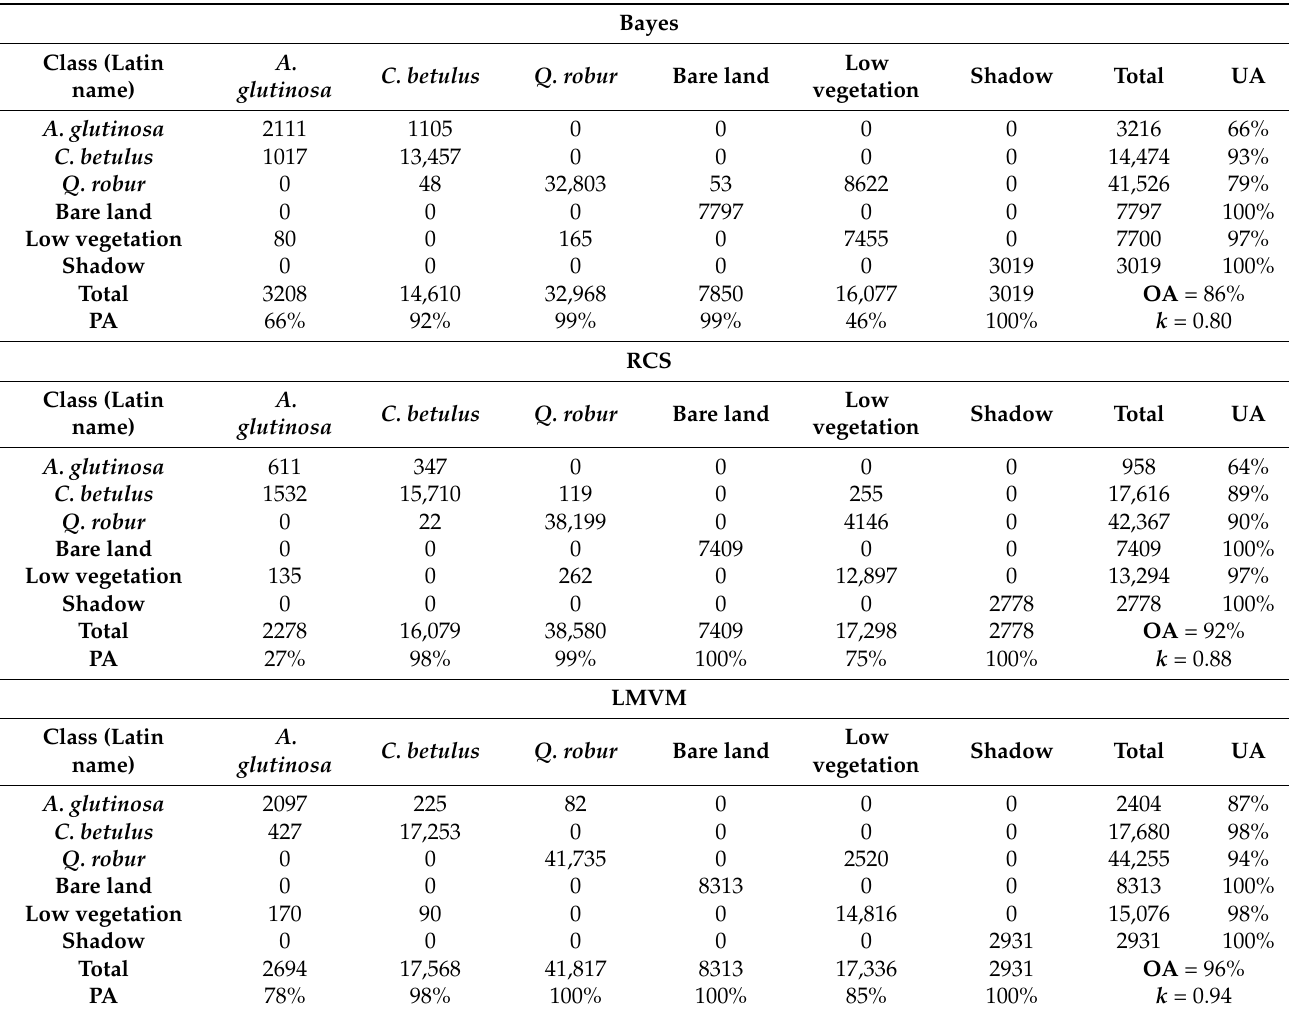
Table 4. Accuracy assessment of object-based classification of the pansharpened imageries (Bayes, RCS, LMVM) performed on validation